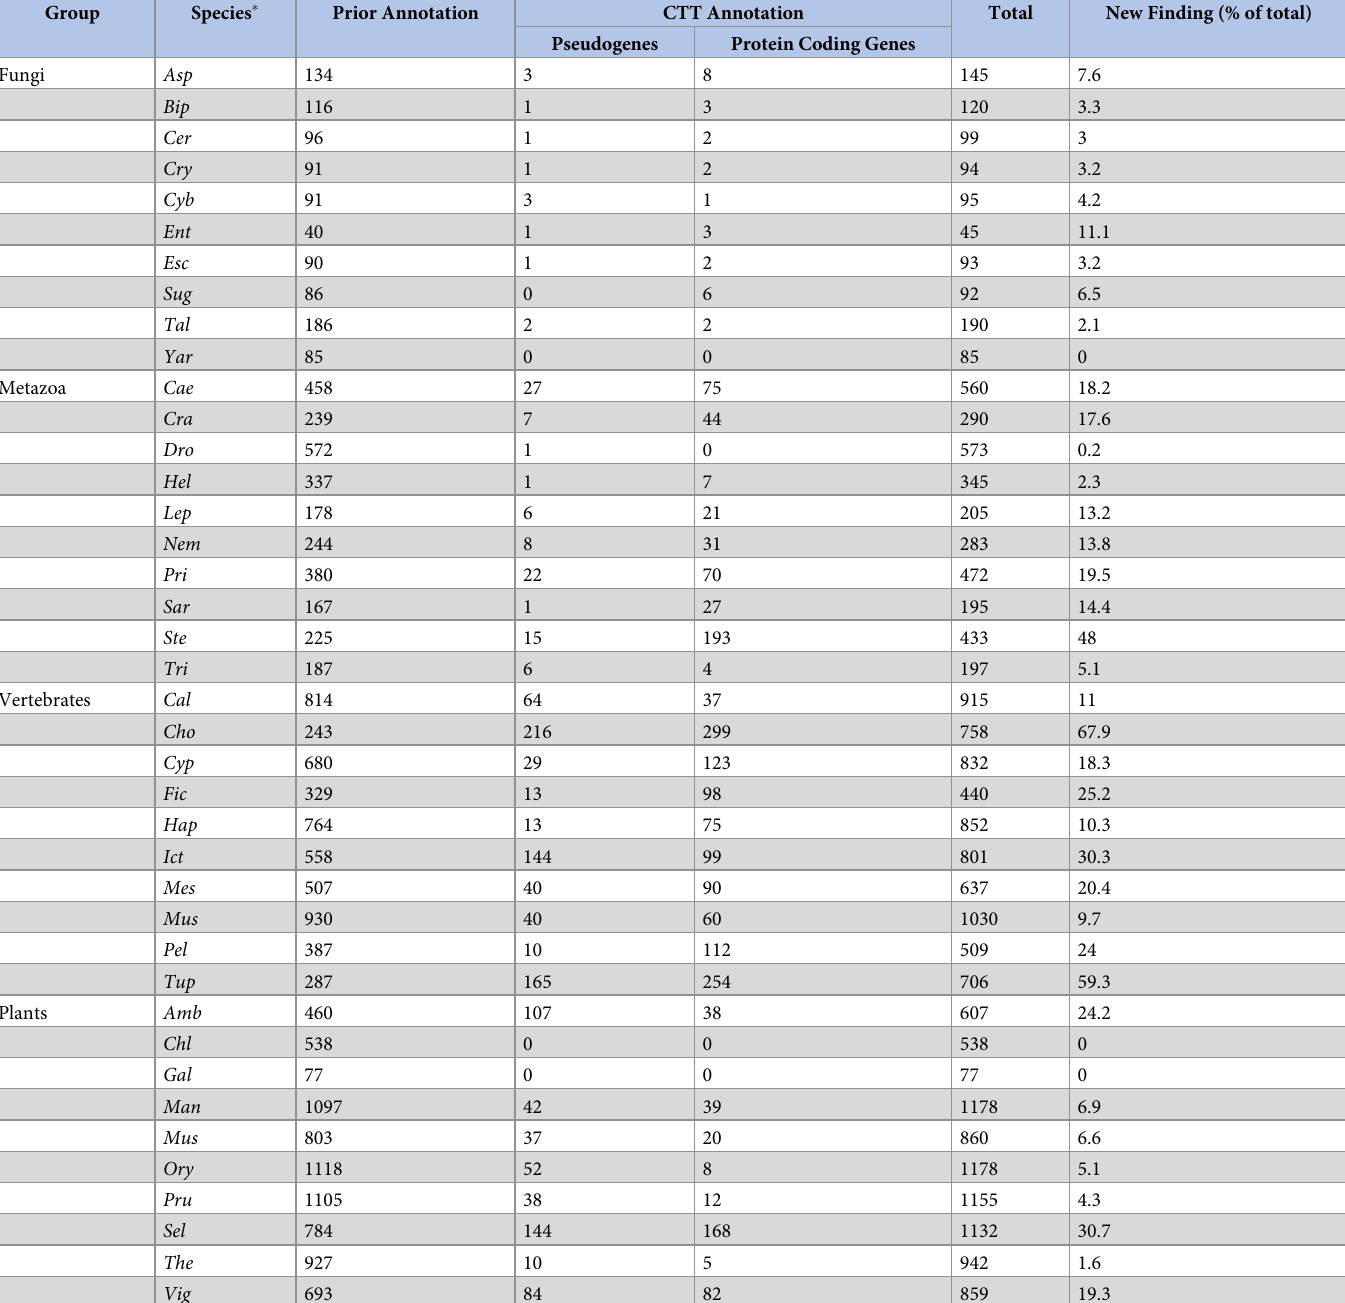
Table 8. CTT annotation results of Pkinase genes in 40 genomes. Group Species � Prior Annotation